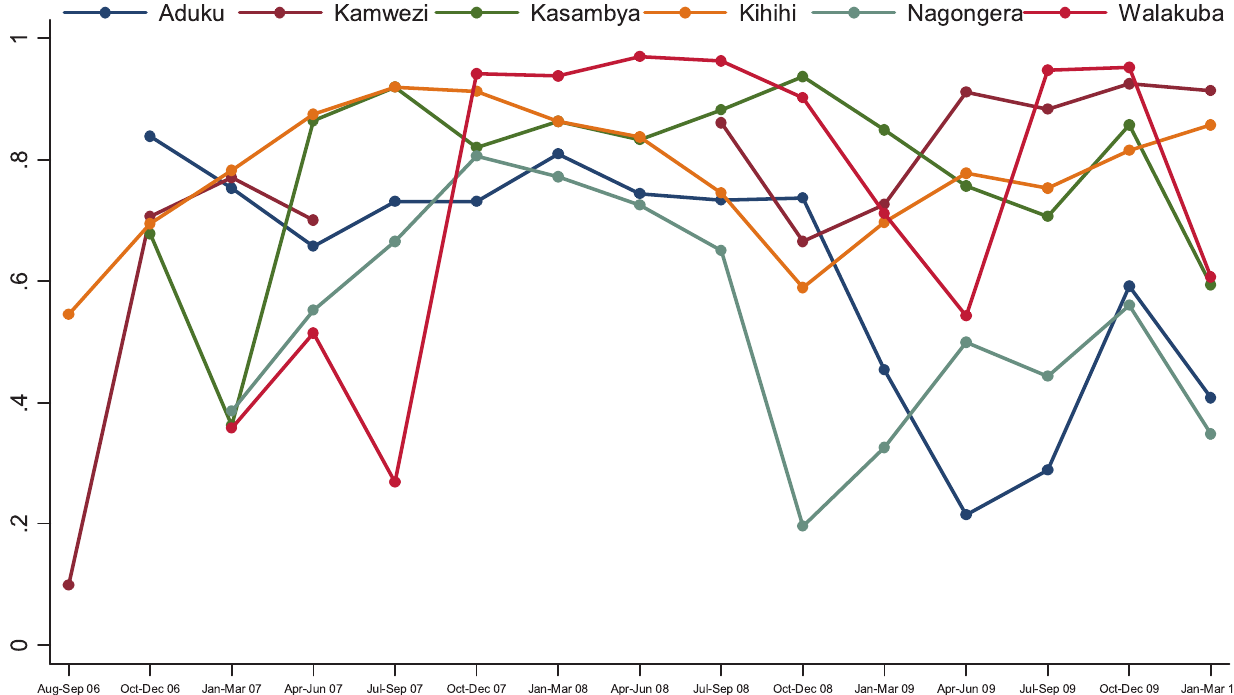
Figure 5. Proportion of patients appropriately prescribed an antimalarial who were prescribed AL by quarter and stratified by site.